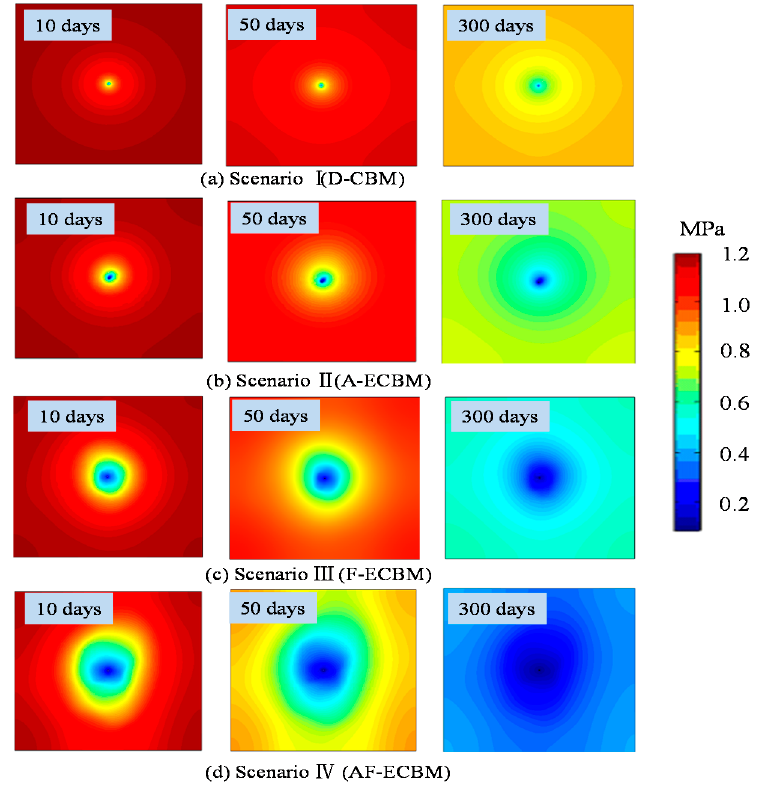
Figure 9. Distribution of gas pressure for different recovery schemes after different extraction duration.